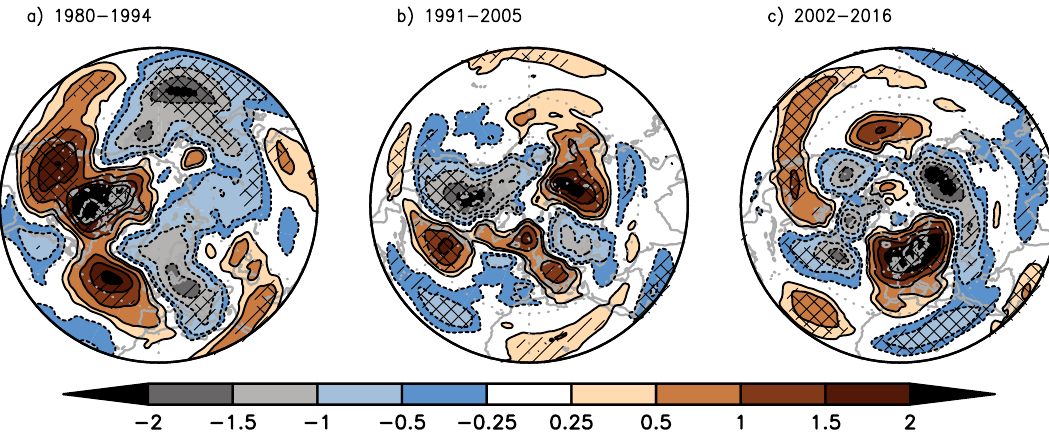
Figure 3. Secular trends (linear regression coefficient) of ZATO in [DU/year] for the three stages: ( a ) 1980–1994, ( b ) 1991–2005, and ( c ) 2002–2016 for January. Cross (single) hatched regions mark statistically significant trends on a 95% (90%) confidence